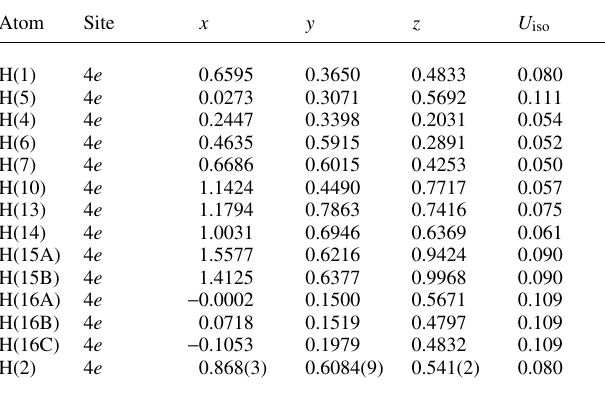
Table 2. Atomic coordinates and displacement parameters (in Å 2 )